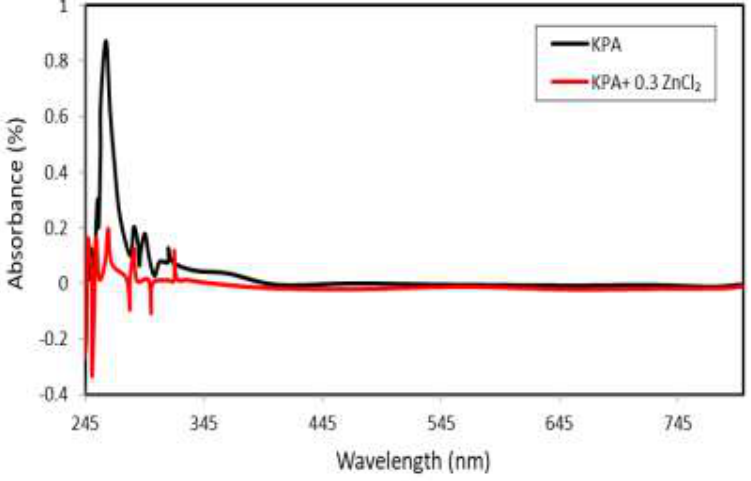
Figure 5: UV-vis spectra of KPA and Zn-PA (0.3ZnCl 2 ).